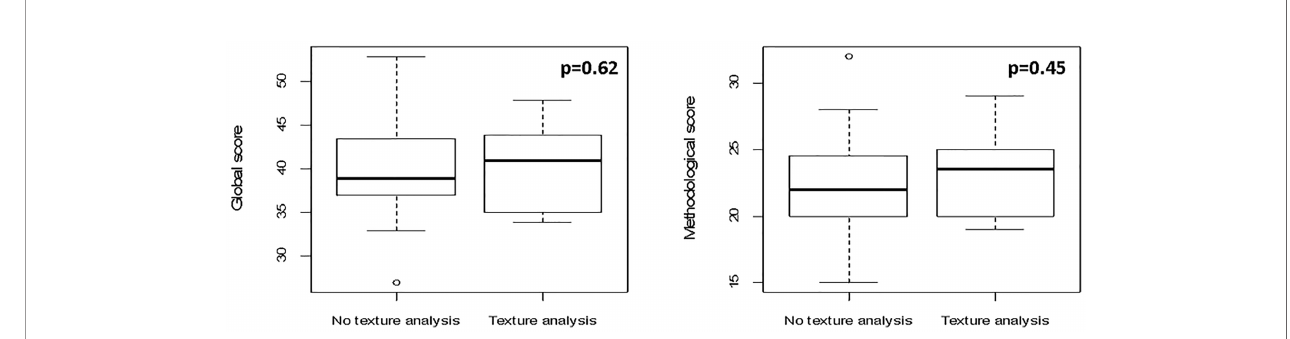
FIGURE 6 | Boxplots representing global and methodological scores (modi fi ed Luo classi fi cation) for the studies included in the analysis, categorized per the presence of